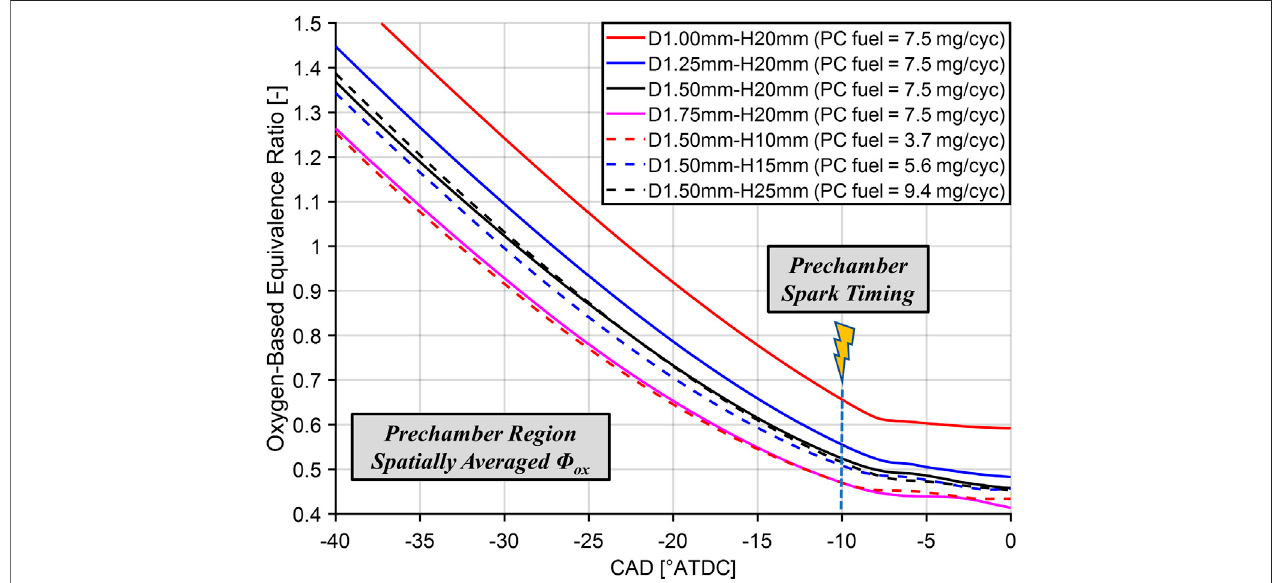
FIGURE 6 | Evolution of the spatially averaged oxygen-based equivalence ratio ( Φ ox ) in the prechamber during the compression stroke for each prechamber geometry investigated.